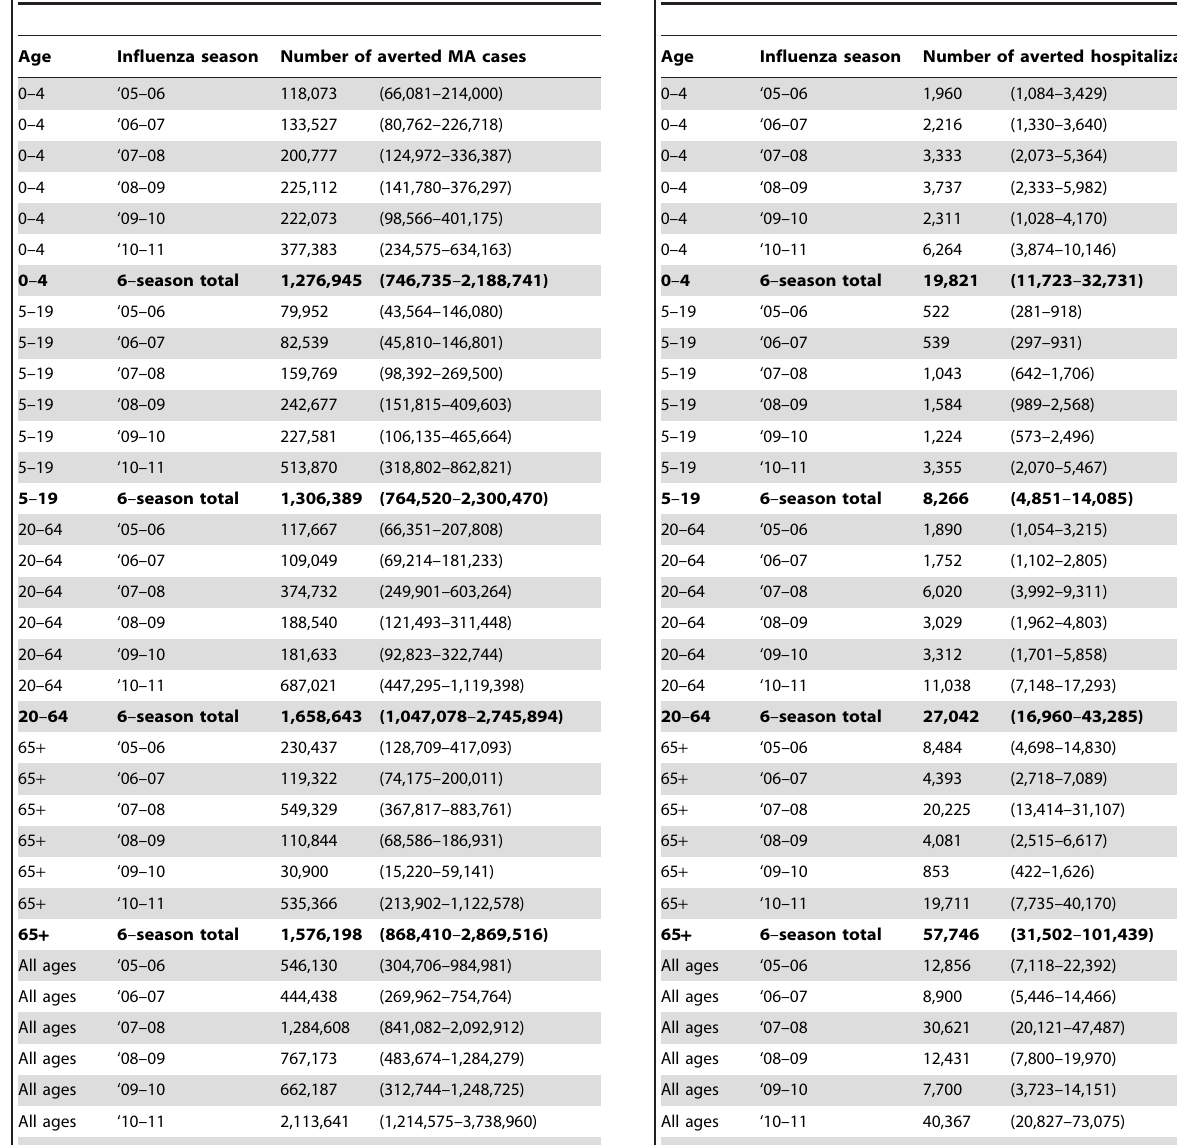
Table 3. Estimated number of medically-attended (MA) influenza cases averted by vaccination, 2005/06–2010/11 influenza seasons (95% confidence interval in parentheses).